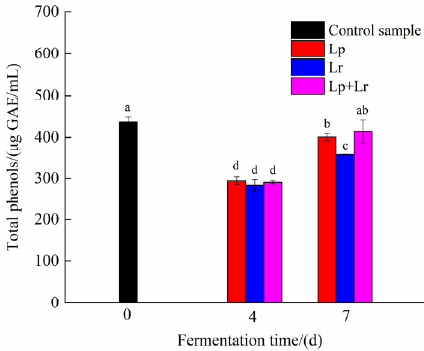
Figure 3. Total polyphenol content of edible grass during fermentation. Different superscript letters in the columns indicate significant difference ( p < 0.05). Abbreviations: Lp, Lactobacillus plantarum ; Lr,